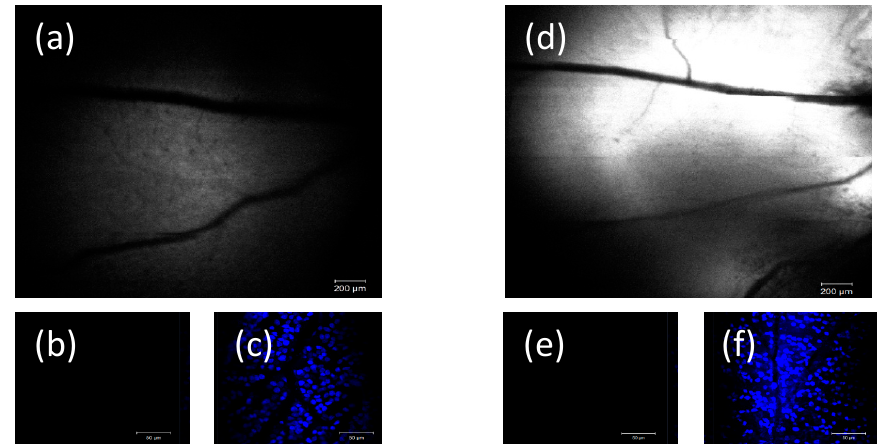
Figure 8. Left and right panels, ( a , d ), example of two different animals injected with different amounts of SPIO-NPs. Two days after intravitreal injection of rhodamine 123-labelled SPIO-NPs, the in vivo images of the retina (ICON) clearly illustrate a dose-dependent fluorescent signal (monocolor image, rhodamine 123 fluorescence). A low concentration of NPs (31 µ g/mL) was injected in ( a ) and a higher concentration of NPs (500 µ g/mL) was injected in ( d ). Note a minor misalignment in the upper right quadrant of image ( d ), due to minor movement of the rat during scanning. However, no rhodamine 123 fluorescence could be detected in retina whole mount preparation from the animals ( b , e ). ( c , f ) images are from the same areas as in ( a , e ) with Hoechst 33342 staining. Scale bars: ( a , d ) 200 µ m; ( b , c , e , f ) 50 µ